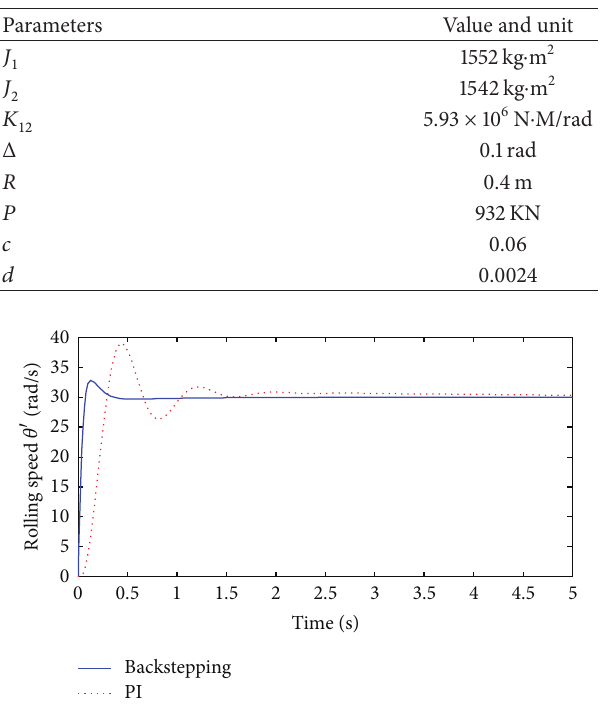
Table 1: Rolling parameters.